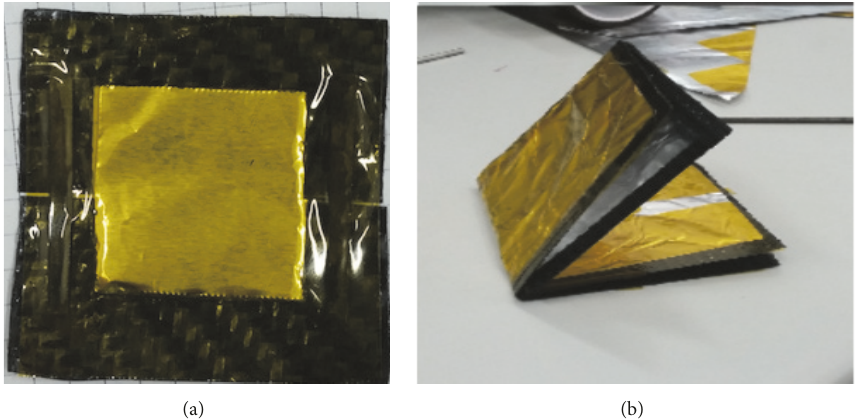
Figure 3: From (a) to (b) an example of the second configuration of solar sail with loom deployed and its folded state.